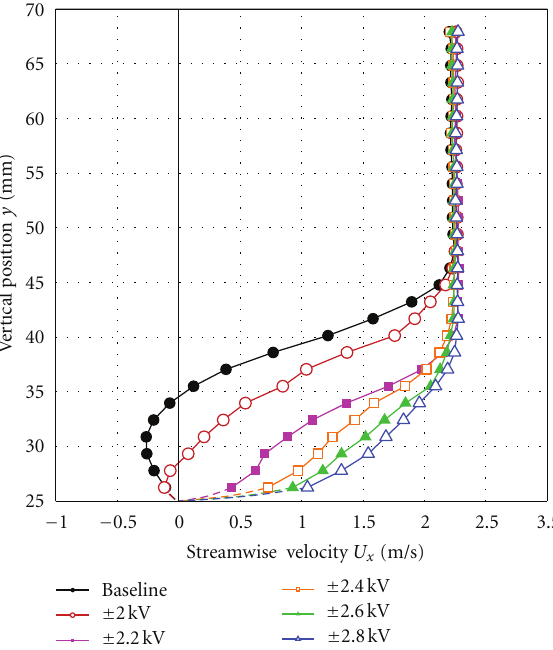
Figure 12: Streamwise velocity distributions near trailing edge ( x = 99.1